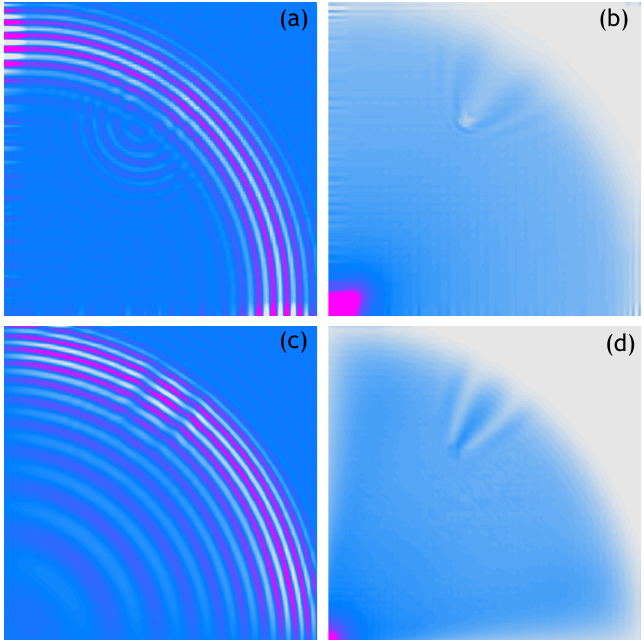
Figure 4. Wave propagation velocity patterns registered at 0.8 ms with 100 × 100 mesh grid, ( a ) Ex- perimental data, ( b ) RMS of experimental data, ( c ) Calculated data, ( d ) RMS of calculated data.